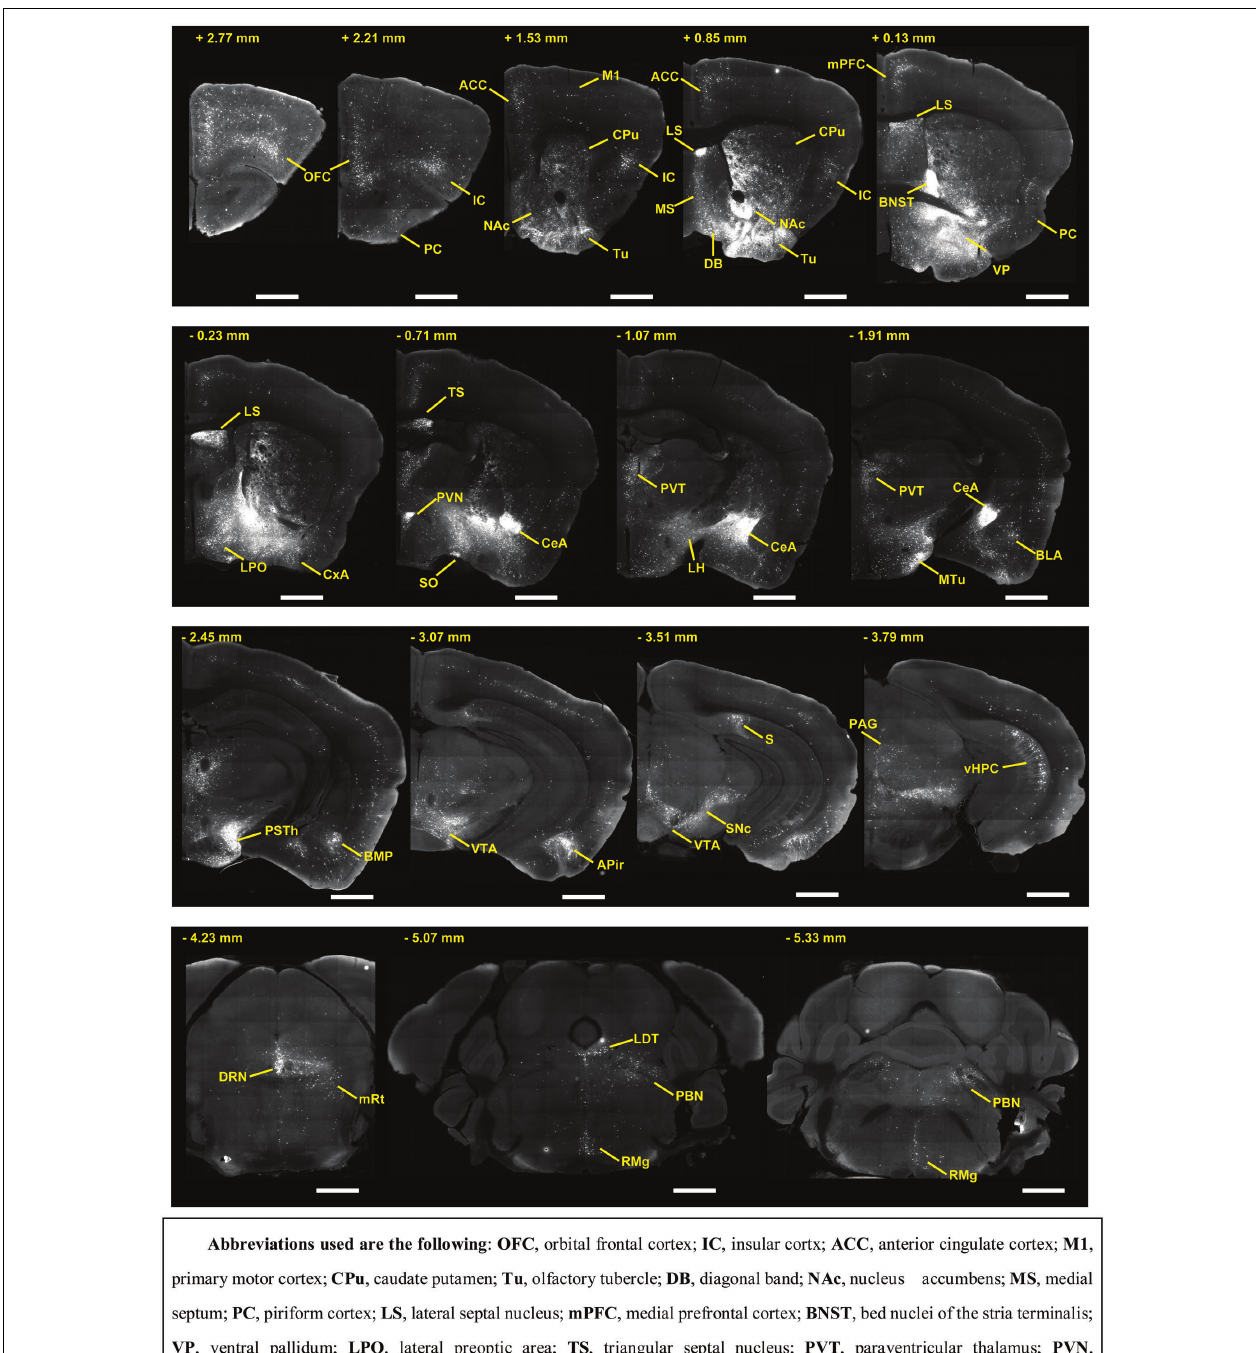
FIGURE 2 | Representative coronal sections showing labeling of monosynaptic inputs to the BFCS. Scale bar: 1 mm.